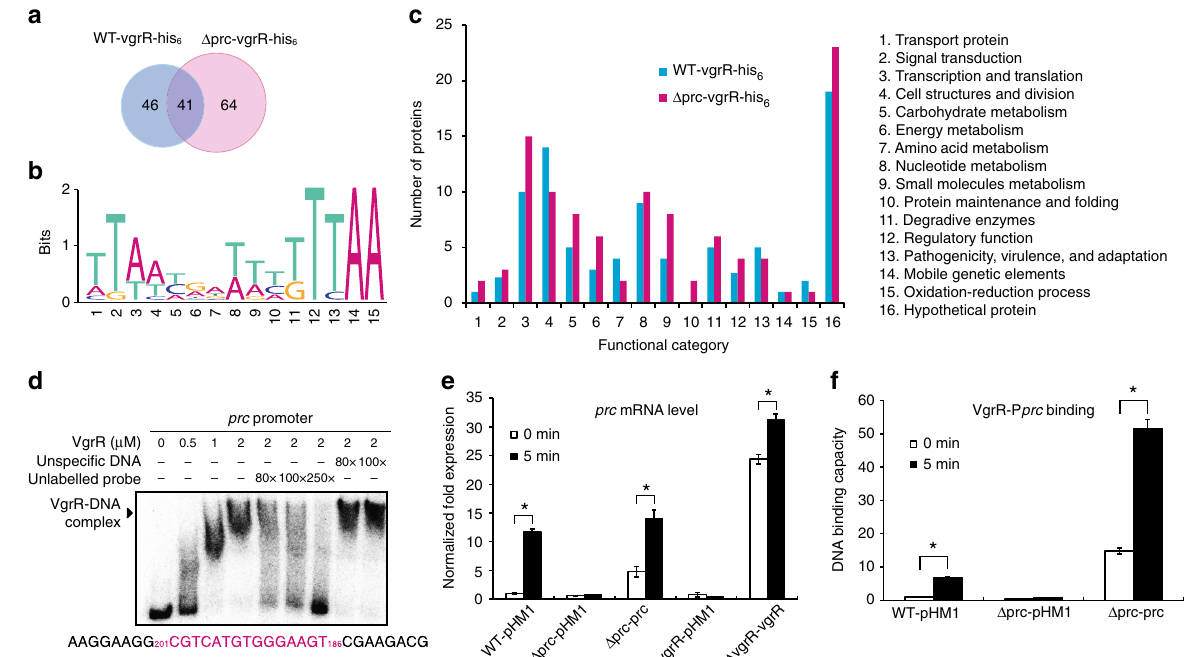
Fig. 7 prc controls the VgrR regulon and VgrR promoter-binding landscapes. a Venn diagram showing the number of genes with promoters that potentially bound to VgrR. ChIP-seq was used to identify the VgrR-binding DNAs. Genes identi fi ed from the WT strain and the prc mutant are shown. b Predicted consensus VgrR-binding DNA motif based on ChIP-seq data. Weblogo was used to show the nucleotide composition. c Functional classi fi cation of the VgrR-regulated genes identi fi ed by ChIP-seq. Gene details are listed in Supplementary Table 4. d An electrophoretic mobility shift assay revealed that VgrR directly bound the promoter region of prc . PCR products of the promoter region were labelled with [ γ - 32 P]ATP and used as DNA probes. Unlabelled DNA and unspeci fi c DNA were used as competitors. The sequence of the DNA probe is shown below, with the VgrR-binding motif in magenta. Numbers indicate the location relative to the translation initiation site. Each experiment was repeated two times. Triangle indicates VgrR – DNA complexes. e vgrR positively controls the transcription of prc . qRT-PCR was used to quantify prc mRNA in different bacterial strains before and after osmostress stimulation (1.0 M sorbitol, 5 min). Ampli fi cation of the cDNA of tmRNA was used as an internal control. A representative of three independent experiments is shown. f Deletion of prc decreases VgrR-promoter binding in bacterial cells. ChIP-qPCR was employed to quantify the enrichment of VgrR at the promoter region of prc under osmostress growth conditions (NYG medium plus 1.0 M sorbitol for 5 min) or no stimulation. The experiment was repeated three times. In e and f , error bars indicate the standard deviations. Asterisks indicate signi fi cant differences relative to the WT strain (Student ’ s t -test, P <